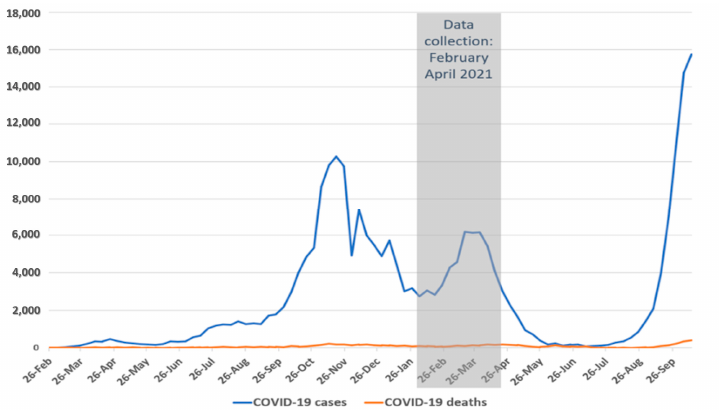
Figure 1. COVID-19 situation in Romania during recruitment. Data from Johns Hopkins